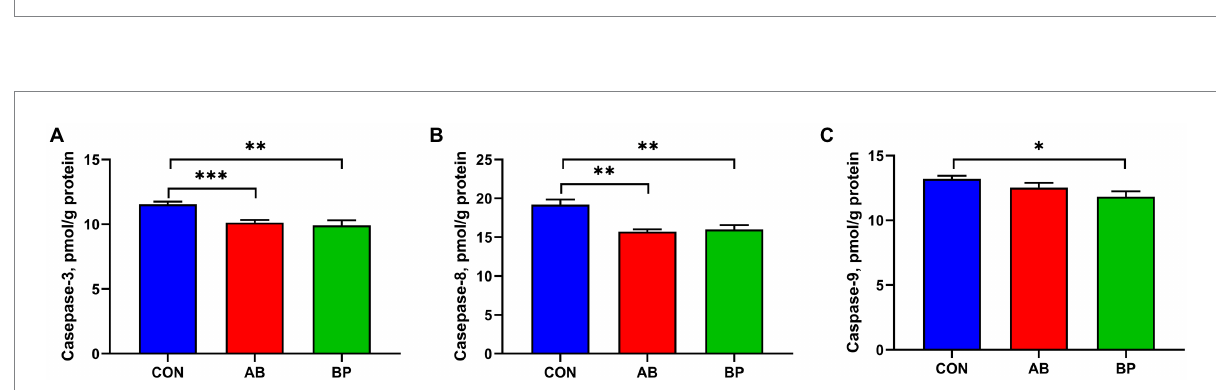
FIGURE 5 Effects of dietary supplemented with Bopu powder on caspases levels of broiler chickens. (A) Caspase-3; (B) Caspase-8; and (C) Caspase-9. CON group, broiler chickens fed a basal diet; AB group, broiler chickens fed a basal diet supplemented with 50 mg/kg aureomycin; BP group, broiler chickens fed a basal diet supplemented with 40 mg/kg Bopu powder containing protopine and allocryptopine. Values are mean ± standard error ( n = 6). * p < 0.05, ** p < 0.01, *** p <